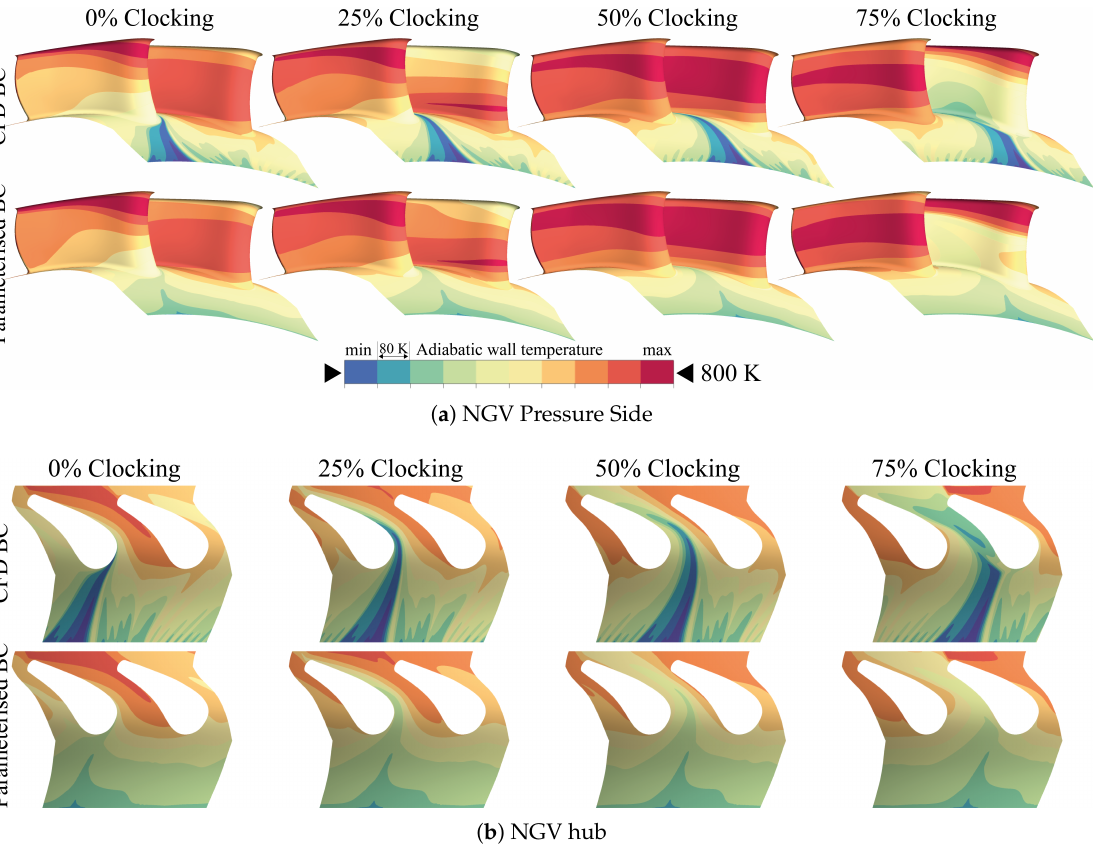
Figure 12. Comparison of adiabatic wall